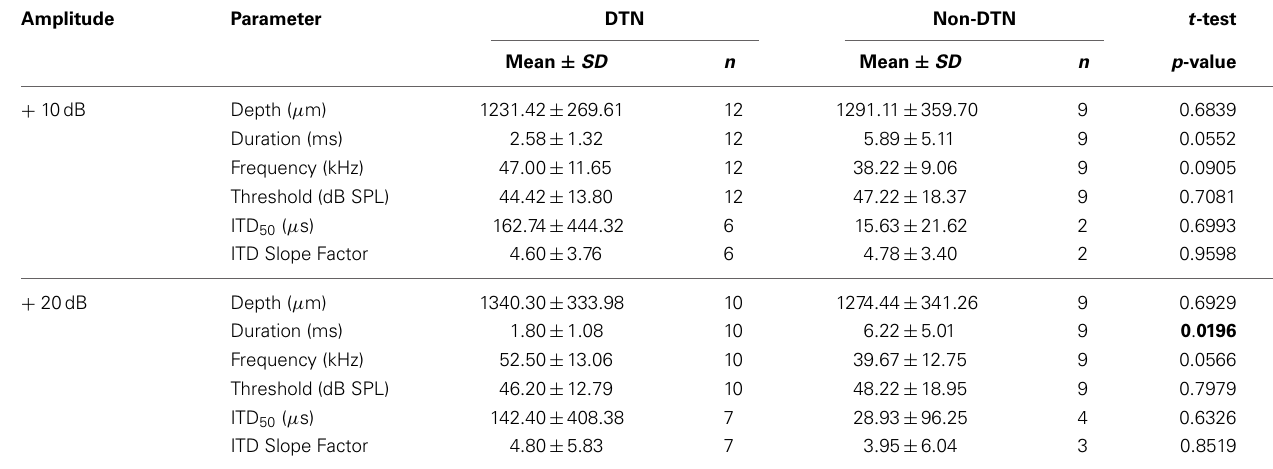
Table 7 | Comparison of electrophysiological parameters of DTNs and non-DTNs with ITD-selective response functions.